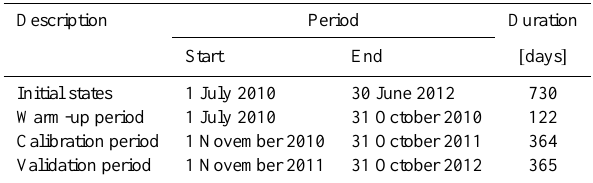
Table 2. Plant ( Setaria sphacelata )- and soil-dependent parameters used for the Shuttleworth–Wallace equation. Parameter Symbol Value Unit Used to Source Potential soil surface resistance r ss pot 500 sm − 1 r ss Federer et al. (2003) Max stomatal conductivity or g max 270 sm − 1 r sc Körner et al. (1979) max leaf conductance Leaf area index Canopy height h Estimate based on Representative leaf width Extinction coefficient for photosynthetically CR active radiation in the canopy